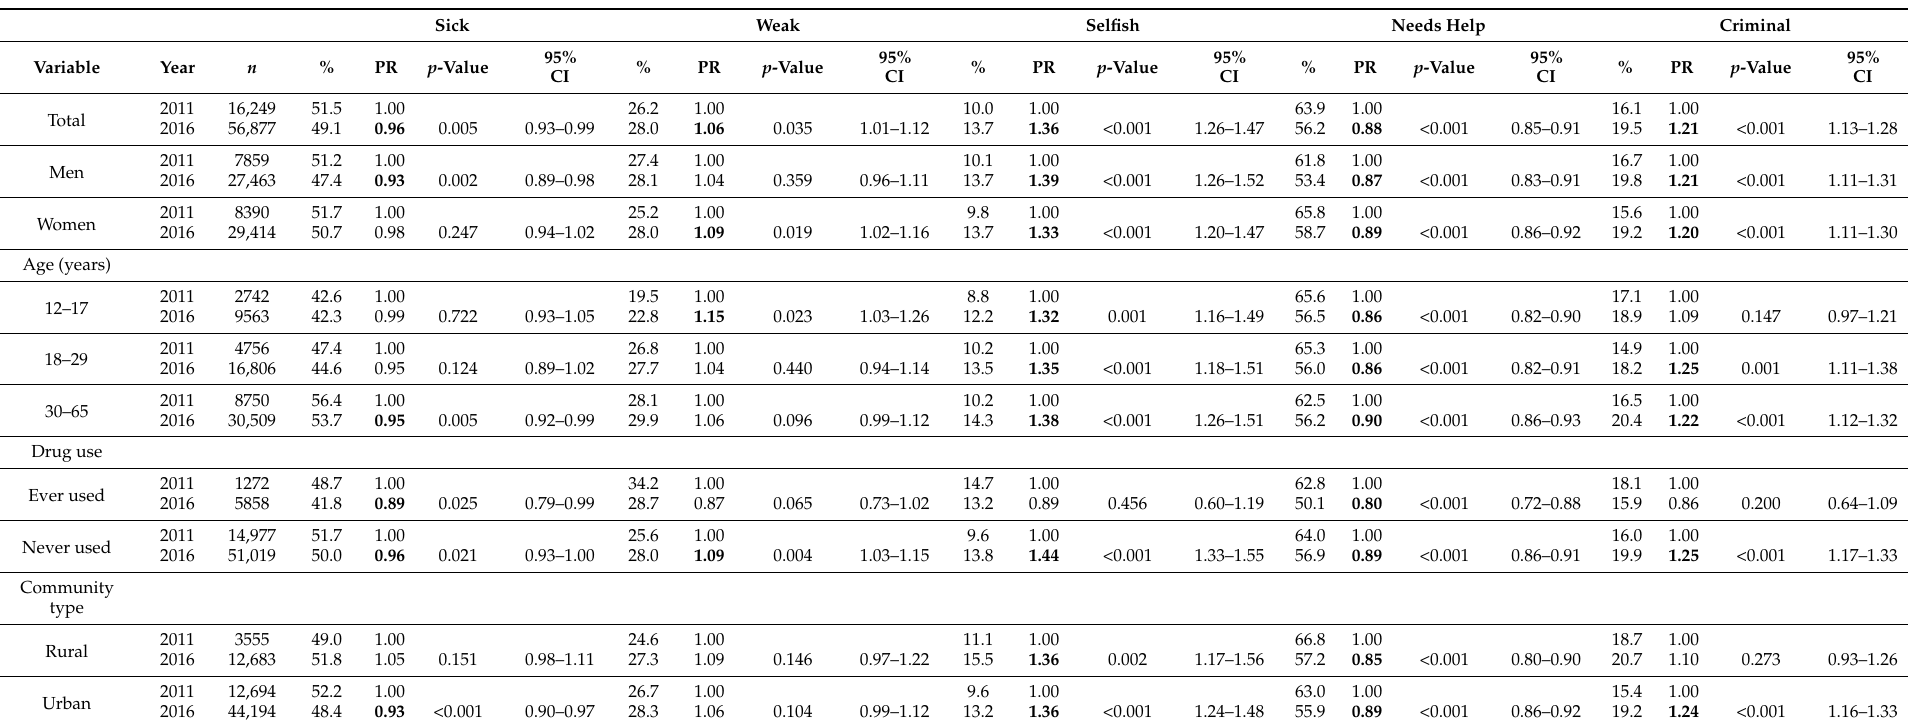
Table 2. Attitudes among the general population toward persons with substance use